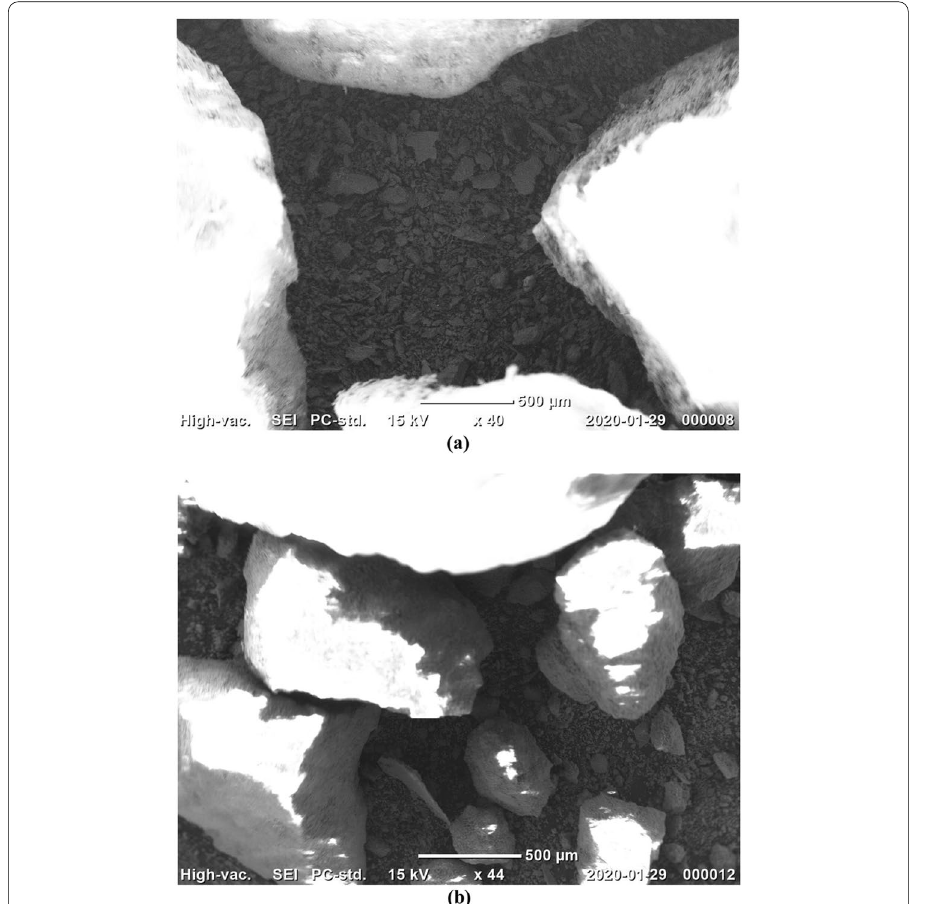
Fig. 8 SEM images: a gap‑graded silty sand; and b Gwanak